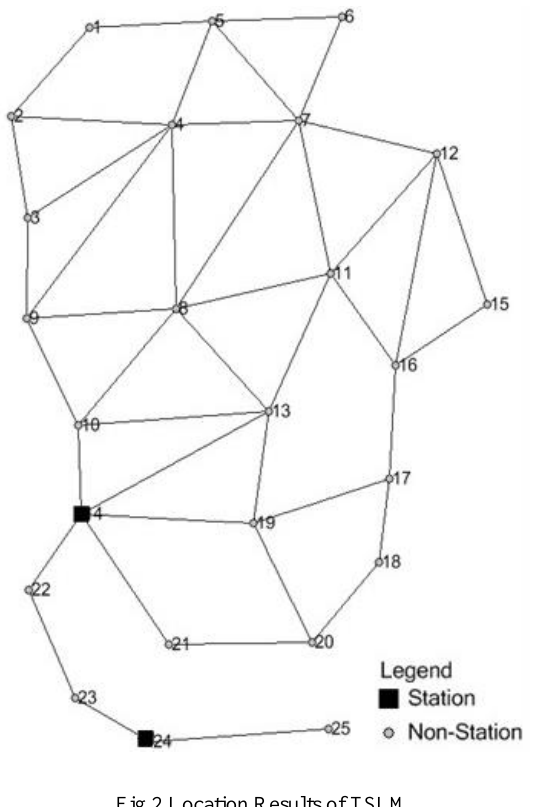
Fig.2 Location Results of